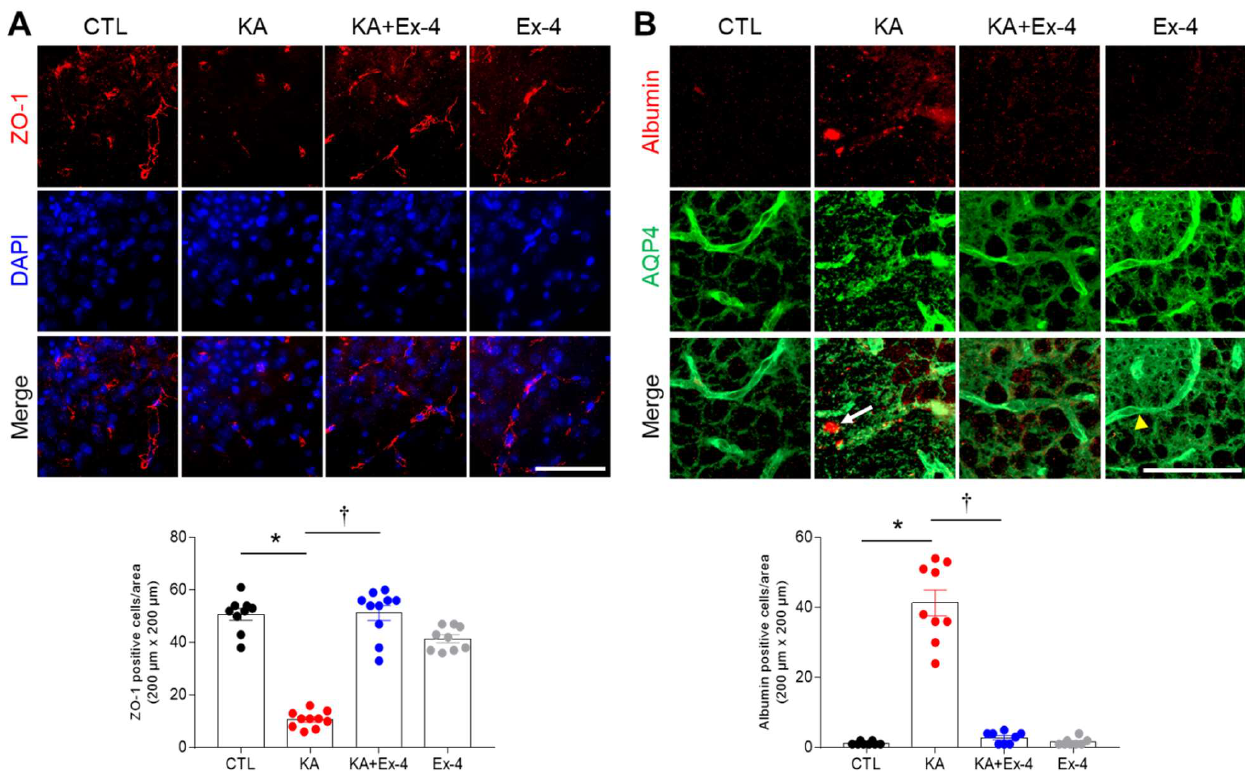
Figure 6. Effect of Ex-4 pretreatment on BBB leakage in KA-treated mouse hippocampus. ( A ) Representative images of immunofluorescence showing ZO-1 in the hippocampal CA3 region 24 h after KA treatment. Quantitative result of ZO-1 positive cells are shown in 8-10 CA3 regions ( n = 3–4 mice per group). Nuclei were stained with DAPI. ( B ) Representative images of double immunofluorescence showing the albumin and AQP4 in the hippocampus 24 h after KA treatment. Quantitative results of albumin-positive cells are shown in 8–10 CA3 regions ( n = 3–4 mice per group). White arrow and yellow arrow head indicate extravascular albumin and blood vessels, respectively. Scale bar = 50 µm. Data ( n = 3–4 mice per group) are presented as mean ± SEM. * p < 0.05 vs. CTL, † p < 0.05 vs. KA. The one-way ANOVA was used to detect any statistically significant differences between groups ( A , B ). A; p values = 0.0001 (KA), 0.0001 (KA + Ex-4), F (3, 34) = 90.11, B; p values = 0.0001 (KA), 0.0001 (KA + Ex-4), F (3, 29) =